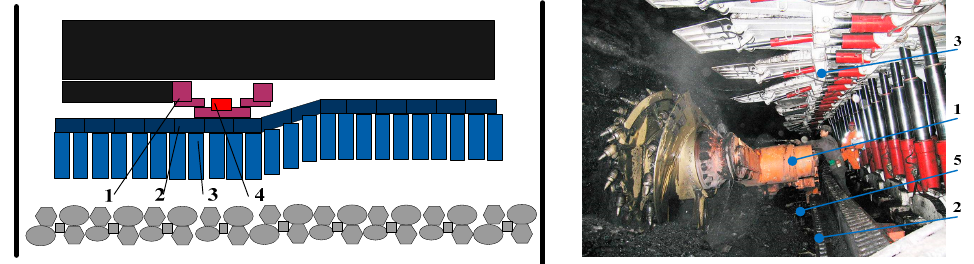
Figure 1. A diagram for the “three-machine” of a fully-mechanized coal face and its realistic scenario. 1—Shearer; 2—conveyer scraper; 3—hydraulic support; 4—SINS; and 5—central trough.